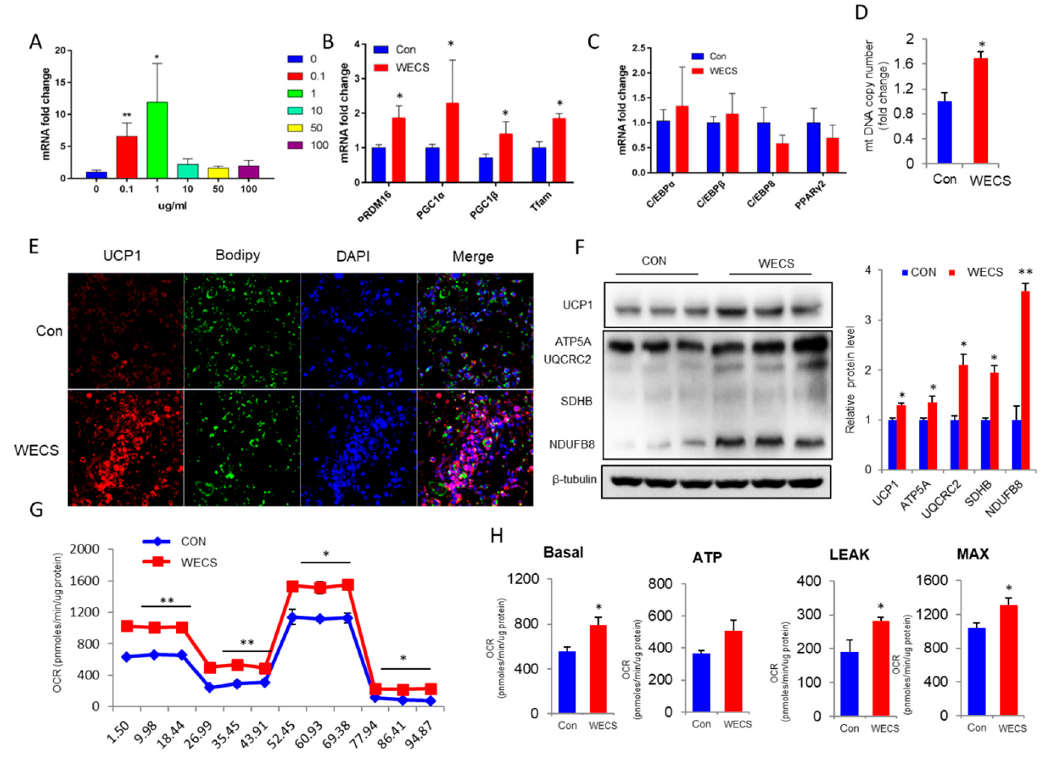
Figure 5. WECS increases mitochondrial biogenesis and oxygen consumption. Dose-dependent e ff ects of WECS on UCP1 expression in brown adipocytes ( A ). Thermogenic and mitochondrial biogenic gene expression in brown adipocytes treated with 1 µ g / mL WECS or DMSO ( B ). The expression levels of adipogenic marker genes ( C ). The mitochondrial copy numbers ( D ). Representative images of UCP1 staining ( E ). The protein levels of UCP1 and OXPHOS in brown adipocyte (F). Brown adipose primary cells were treated with 1 µ g / mL WECS or DMSO during 6 days of brown adipogenesis; OCR at day 6 ( G ). The OCR-related basal metabolic rate, ATP levels, maximum oxygen consumption, and proton leakage, were all significantly increased ( H ). Bars represent the mean + SEM, n = 3–5. * p < 0.05, ** p < 0.01 compared with the HFD control.